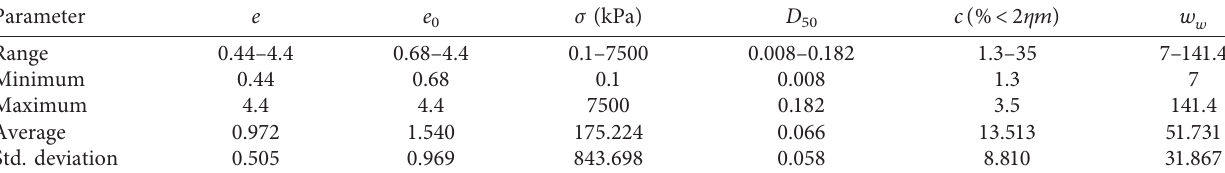
Table 2: Statistical properties of the